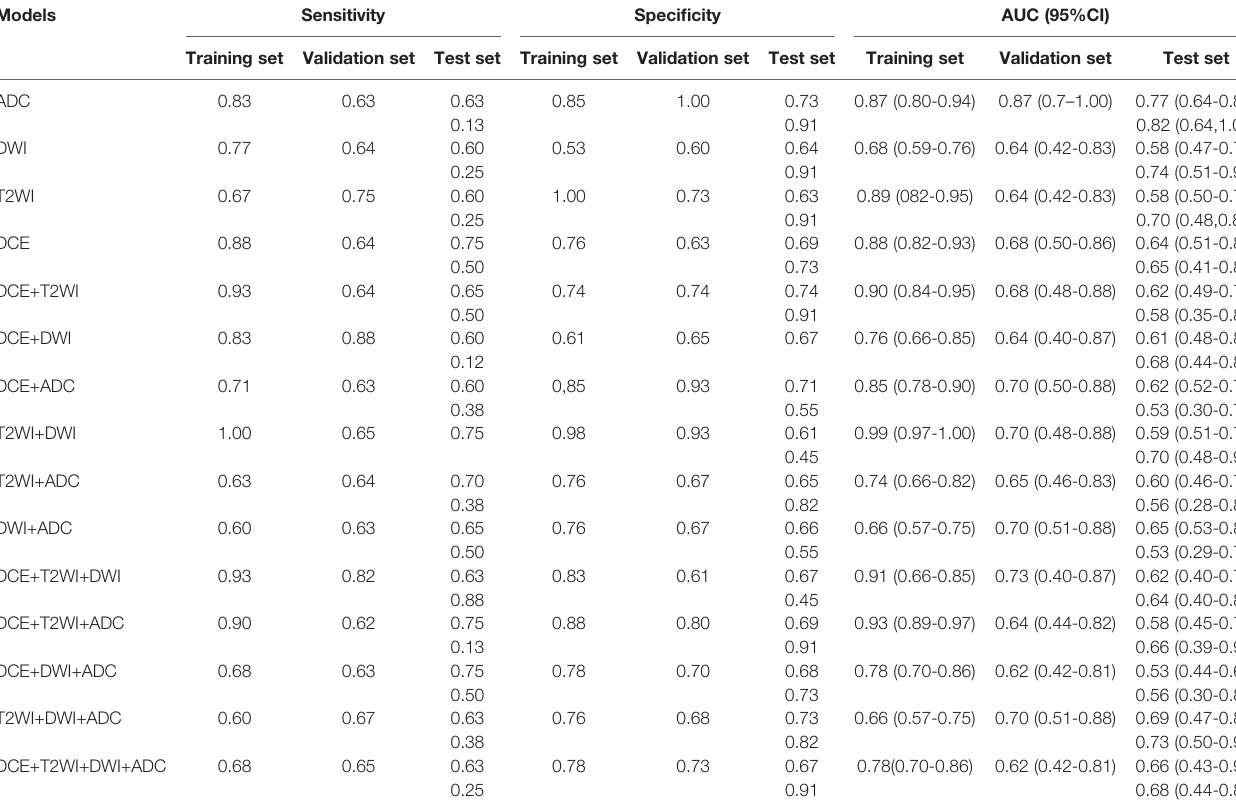
TABLE 3 | Predictive performance of single-layered and fusion radiomic models.